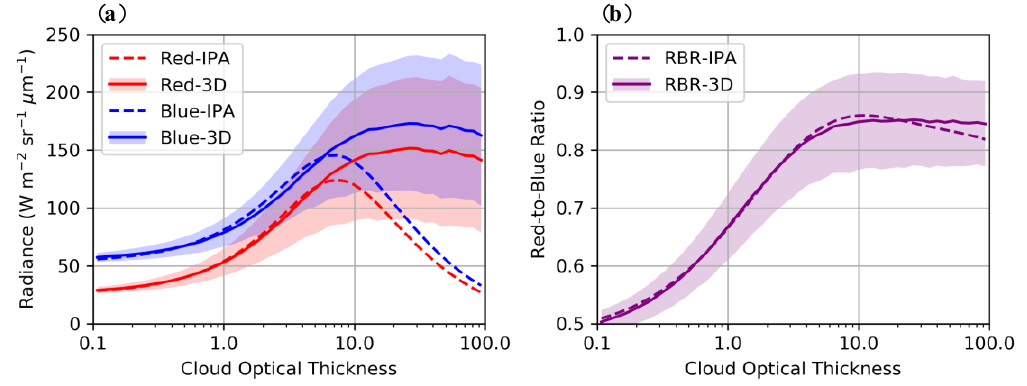
Figure 3. ( a ) Spectral radiances of red and blue channels and ( b ) RBR, computed using the IPA and 3D radiative transfer as functions of COT, for the case in Figure 2. For the 3D results, solid lines and shaded areas denote the mean and standard deviation, respectively, of the values computed for each COT bin, where 30 bins are spaced equally on a logarithmic scale.